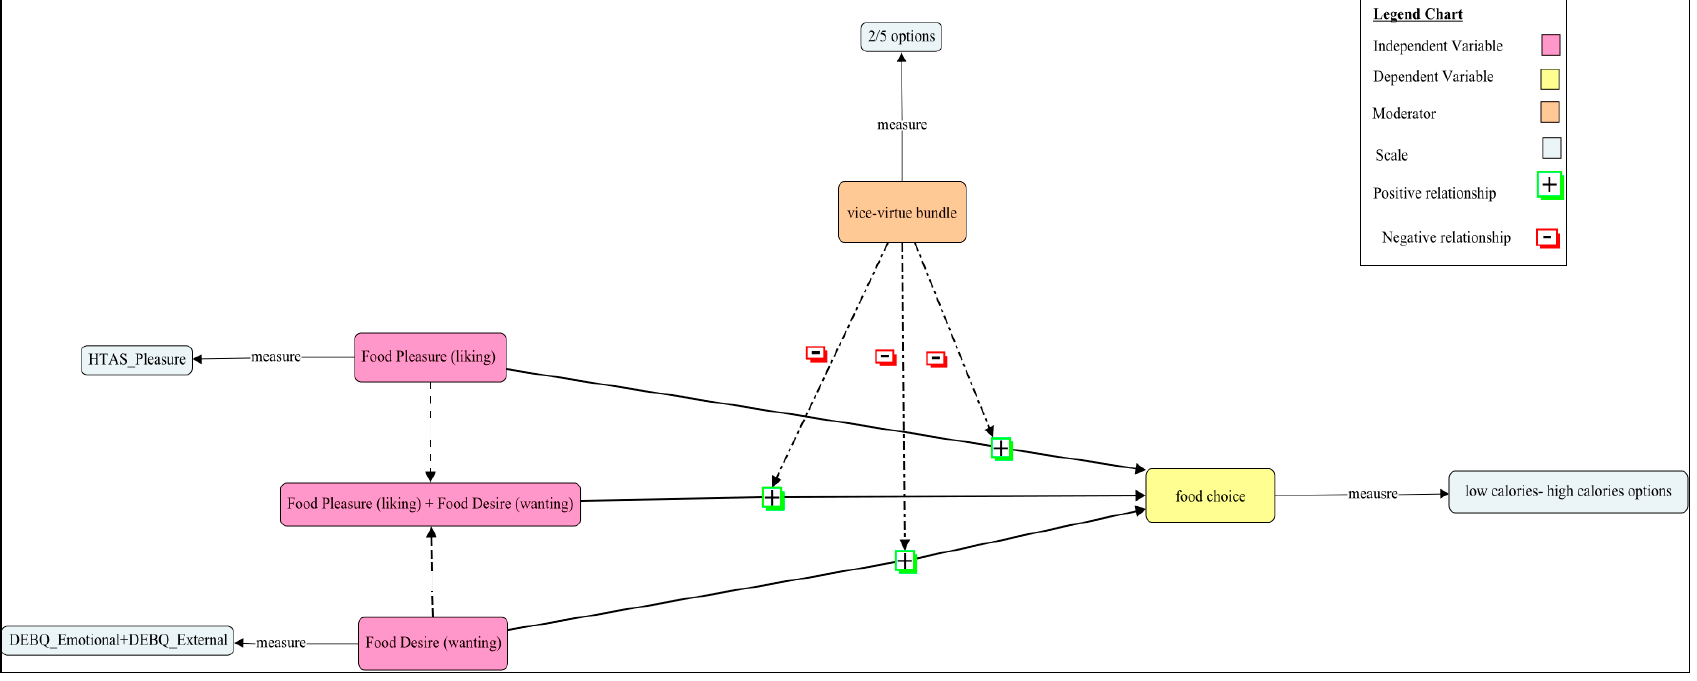
Figure 1. Food reward and food choice conceptual model.